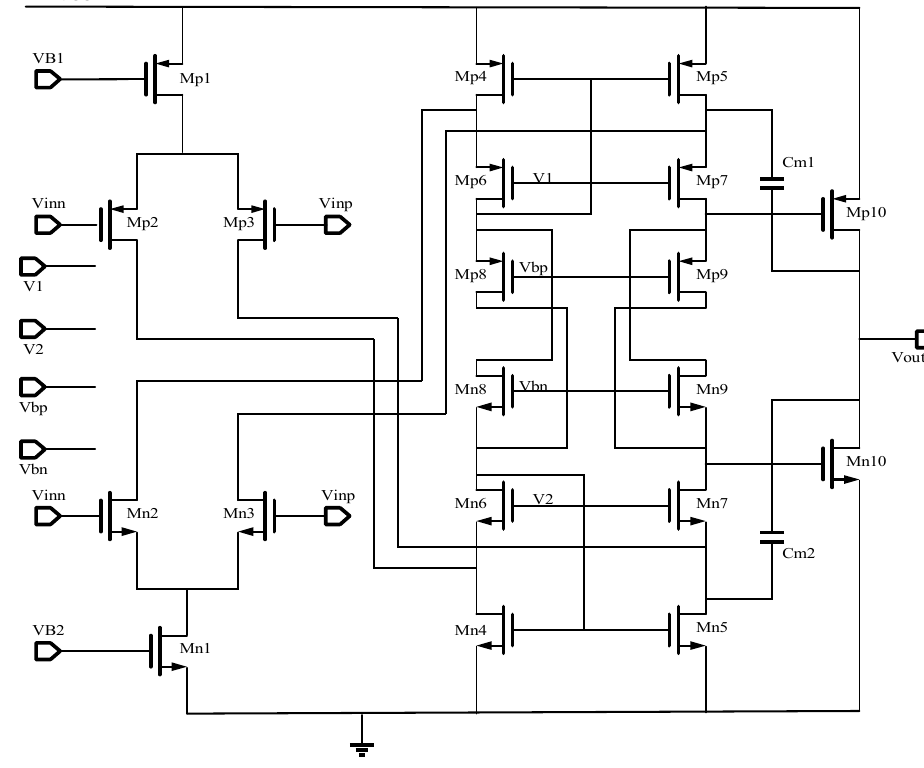
Figure 9. The topology of the post amplifier.